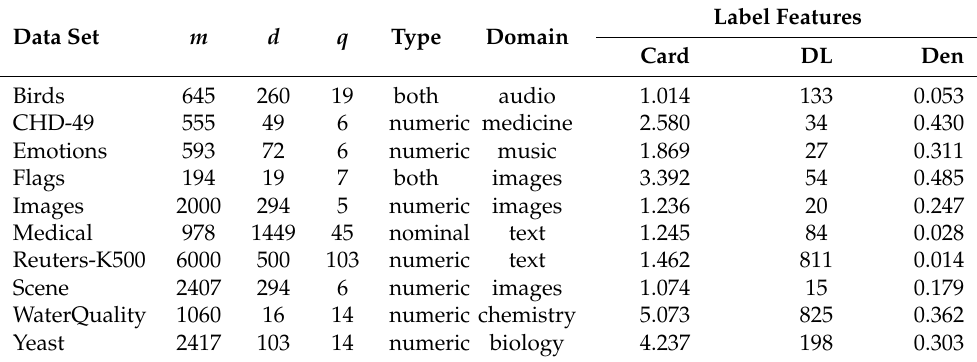
Table 1. Characteristics of the 10 multi-label data